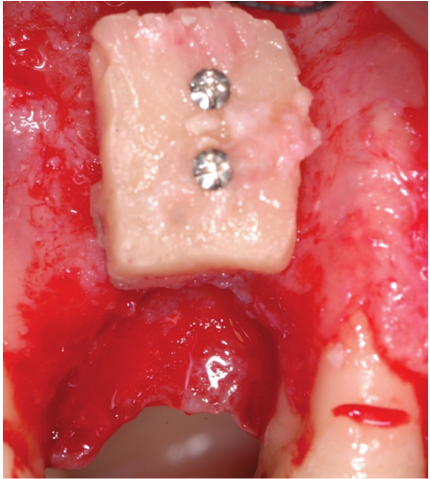
Figure 7: Bone block fixed to the vestibular cortex of the edentulous ridge by means of two transcortical screws.